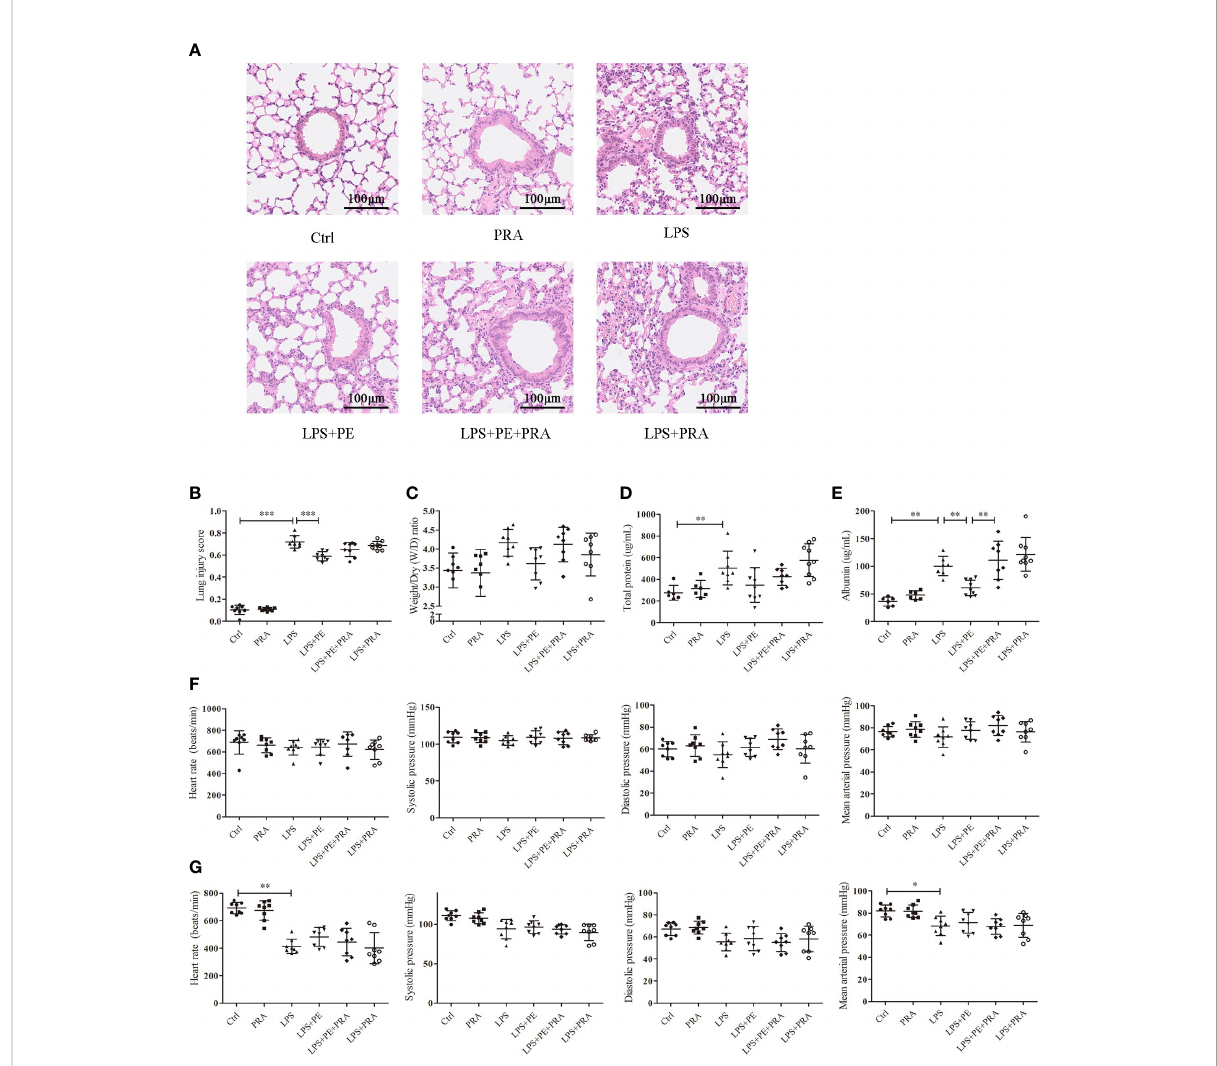
FIGURE 5 Prazosin (PRA) reversed the effect of phenylephrine (PE) on lung pathological injury and alveolar capillary barrier disruption without in fl uencing the cardiovascular haemodynamic of ARDS mice. Mice were given an intratracheal instillation of 2 mg/kg lipopolysaccharide (LPS) to induce ARDS. PRA and PE were also injected into the trachea 40 min or 20 min before LPS stimulation. Lung tissues and bronchoalveolar lavage fl uid (BALF) were collected 24 h after LPS stimulation. (A) Haematoxylin and eosin staining of lung slices. Scale bar = 100 m M. (B) Histology scores of lungs were judged according to guidelines of the American Thoracic Society. (C) Wet/dry weight ratio of lung tissues. (D) Levels of total protein in BALF. (E) Levels of albumin in BALF. (F) Heart rate (HR), systolic blood pressure (SP), diastolic blood pressure (DP), and me an artery pressure (MAP) of mice were monitored before establishing ARDS model. (G) HR, SP, DP, and MAP of mice were monitored 24 h after establishing ARDS model. Data are represented as the mean ± SD, n = 6 – 9 per group. * p < 0.05, ** p < 0.01, *** p <